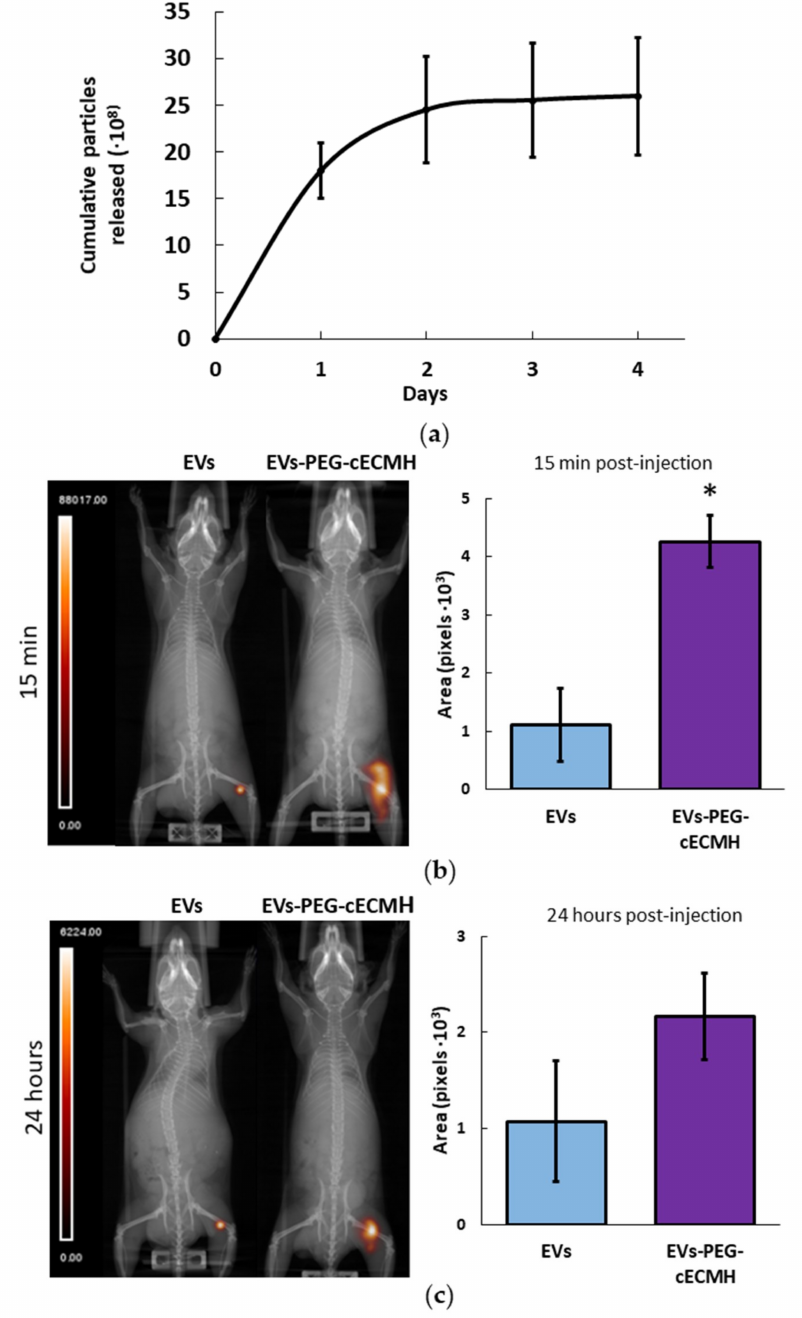
Figure 5. EV release from the EVs–PEG–cECMH and EV in vivo retention. ( a ) Number of